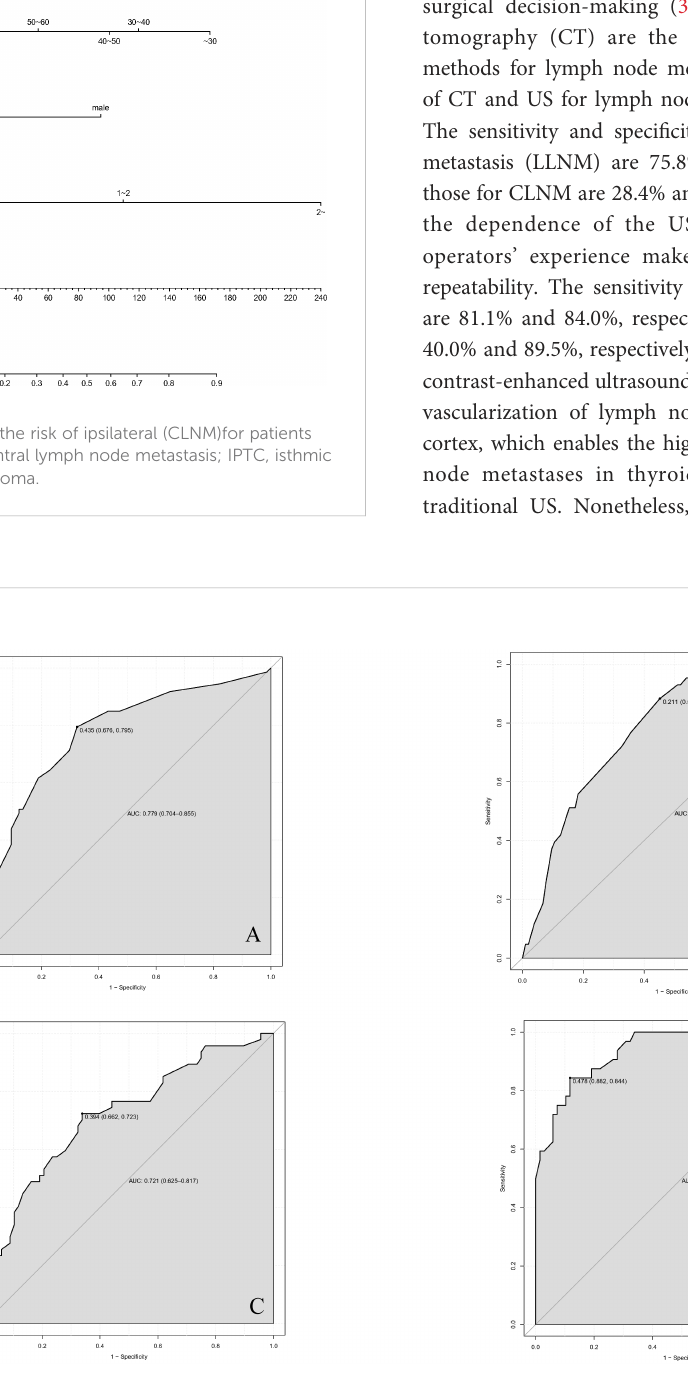
FIGURE 4 Receiver operating characteristic (ROC) curves in (A) ipsilateral central lymph node metastasis (CLNM), (B) contralateral central lymph node metastasis (CLNM), (C) 1-4 central lymph node metastasis (CLNM), (D) >5 central lymph node metastasis (CLNM) for nomogram models. AUC(A) =0.779 (95%CI,0.704-0.855); AUC(B)=0.779 (95%CI,0.702-0.855); AUC(C)=0.721 (95%CI,0.625-0.817); AUC(D)=0.938 (95CI%,0.894-0.981) ROC, receiver operating characteristic curves; AUC, area under the curve. CLNM, central lymph node metastasis. CI, con fi dence